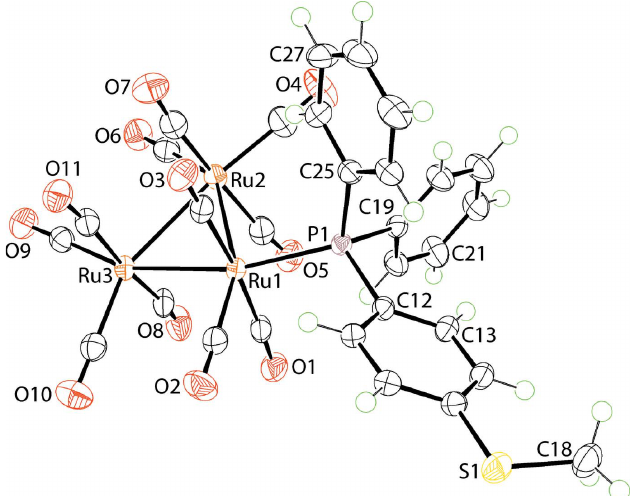
Figure 1 The molecular structure of (I) showing the atom-labelling scheme and displacement ellipsoids at the 70% probability